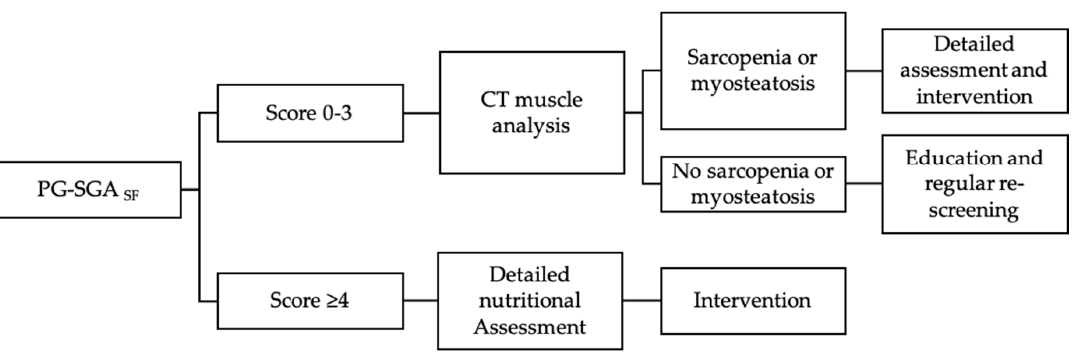
Figure 3. Proposed clinical flow for surgical oncology patients starting with nutrition screening, followed by CT muscle analysis for patients with low screening scores, to identify patients with skeletal muscle aberration in the absence of overt nutrition risk.